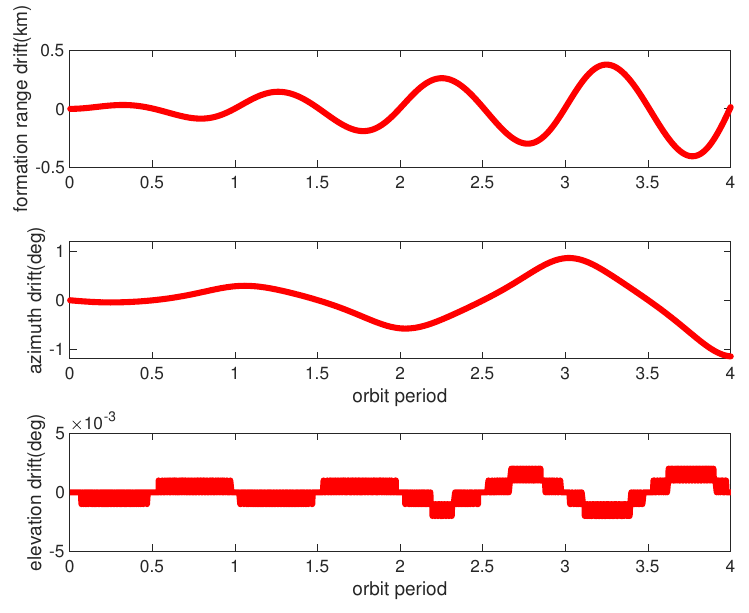
Figure 13. Formation range and azimuth/elevation angles bias under real orbit perturbations. The red lines represent the bias of real formation range drift from the designed values ( top ) and the azimuth/elevation angle drift ( middle / bottom